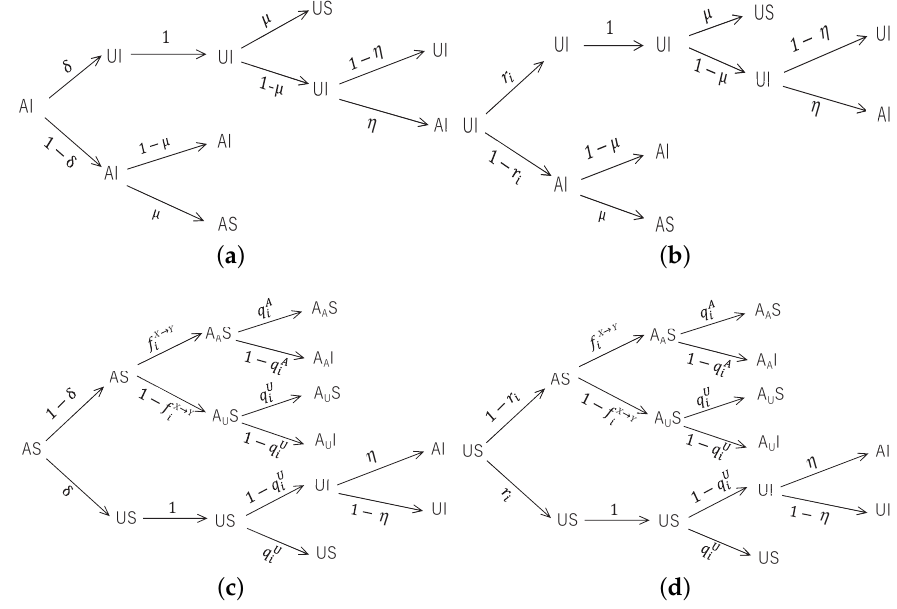
Figure 2. Transition probability trees for the states ( a ) AI, ( b ) UI, ( c ) AS, ( d ) US. Each tree includes four stages: information diffusion (UAU process), feedback from the information layer to the physical layer, epidemic spreading (SIS process), and feedback from the physical layer to the information